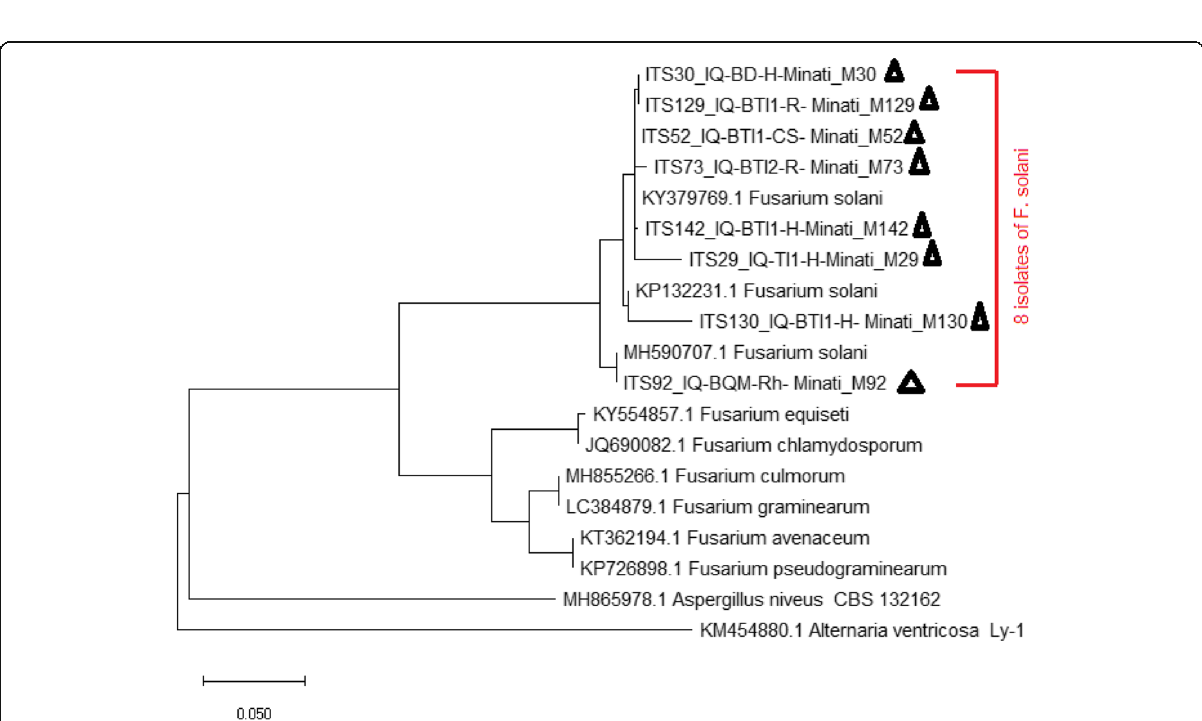
Fig. 9 Phylogenetic tree generated with the ITS-rDNA sequences of the Fusarium solani (8), as inferred from the maximum likelihood (ML) analyses (determined by black triangles) and related species retrieved from GenBank. ITS sequences of Aspergillus niveus (MH865978) and Alternaria ventricosa (KM454880) were used as the out-group